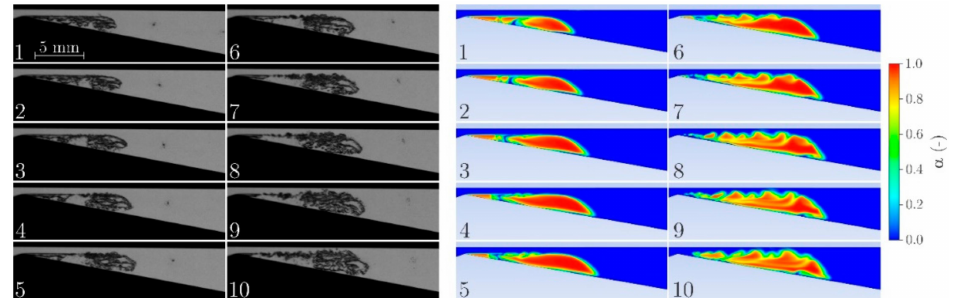
Figure 4. Separation of cavitation clouds and Kelvin-Helmholtz instability formation (experiment: · m = 9.15 g/s, ∆ p = 4.00 bar, σ = 1.24; simulation: difference between the images is ∆ t = 100 µ